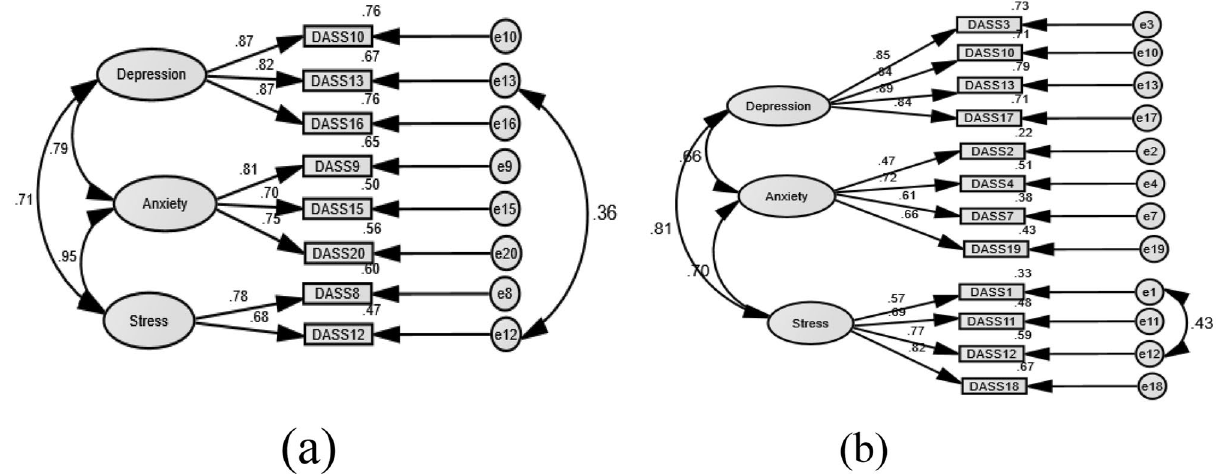
Figure 1. Factor structure of the short versions of the Depression Anxiety Stress Scale (DASS)-21: the DASS-8 ( a ) and the DASS-12 ( b ) among women with chronic pelvic